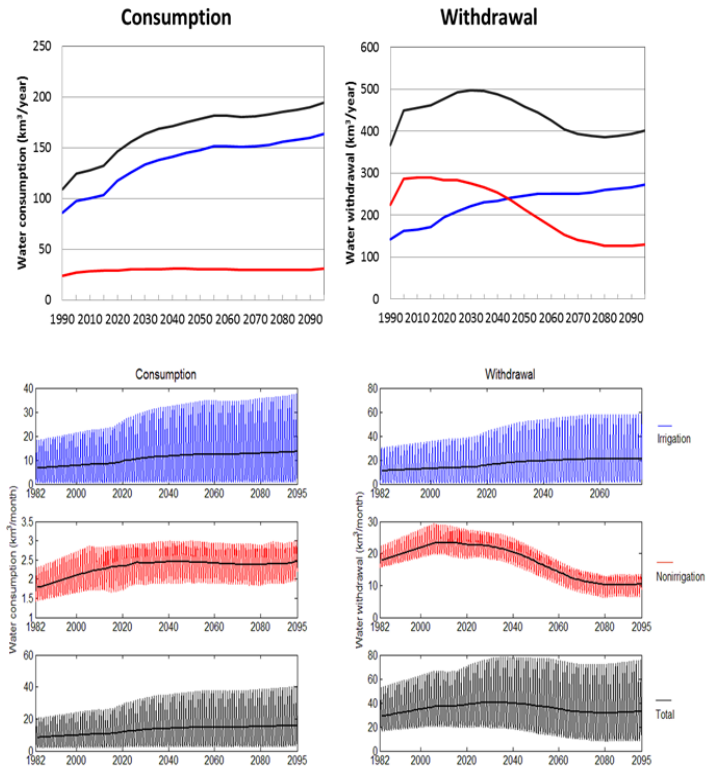
Fig. 5a. (a) Annual water demand by sector from GCAM for the time period 1990–2095 under B1 scenario. (b) Monthly downscaled water Figure 5a: (a) Annual water demand by sector from GCAM for the time period of 1990-2095 under B1 scenario. (b) 2 Monthly downscaled water demand by sector for the time period of 1982-2095 under B1 scenario. 3 demand by sector for the time period 1982–2095 under B1 scenario.